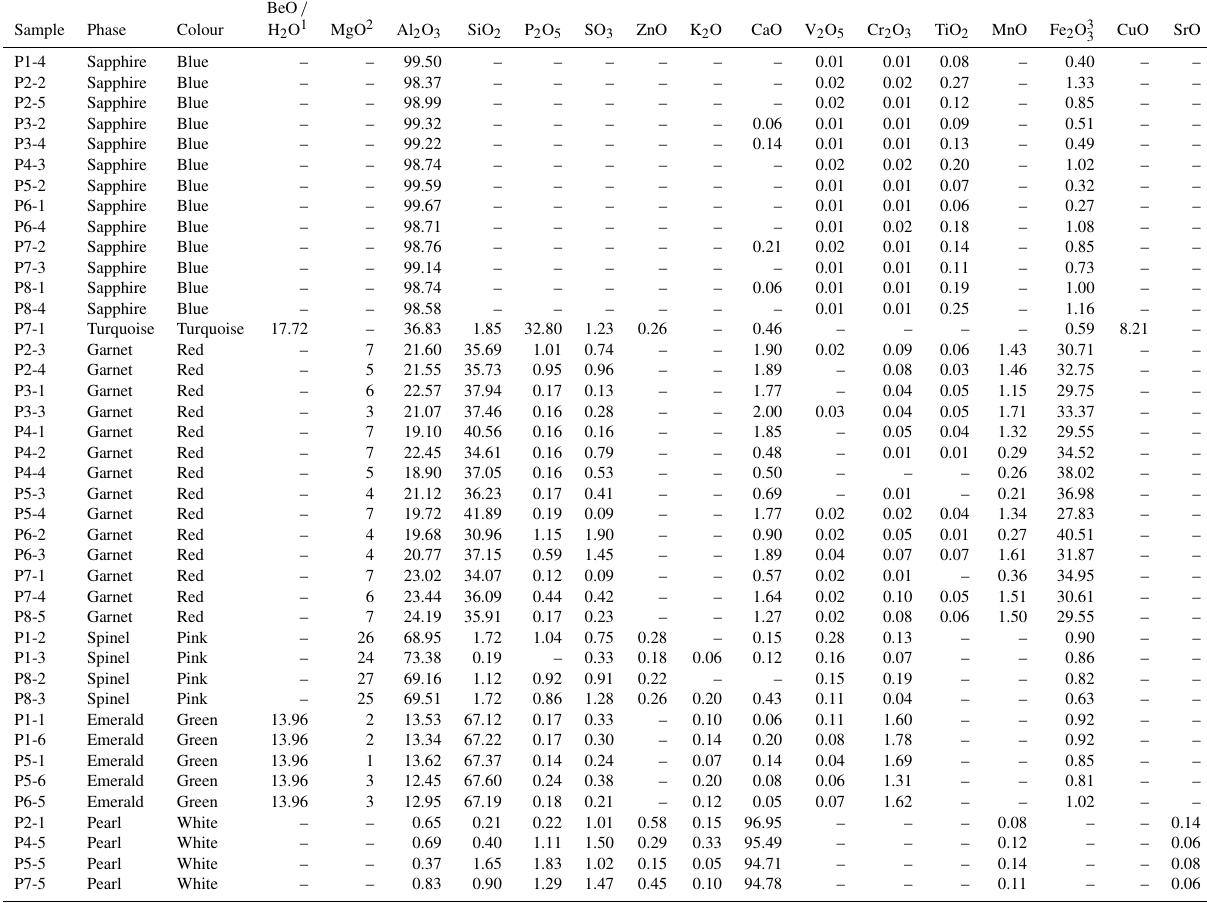
Table 1. Chemical composition of gems and pearls decorating the crown of Namur.